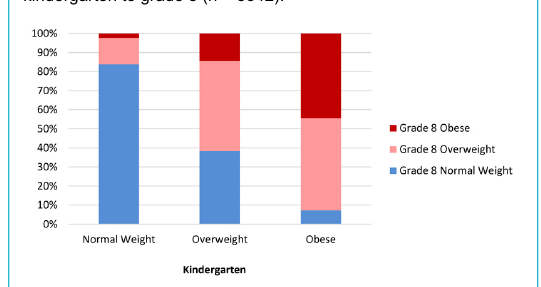
Figure 4: Prevalence of changes in weight status categories from kindergarten to grade 8 (n =